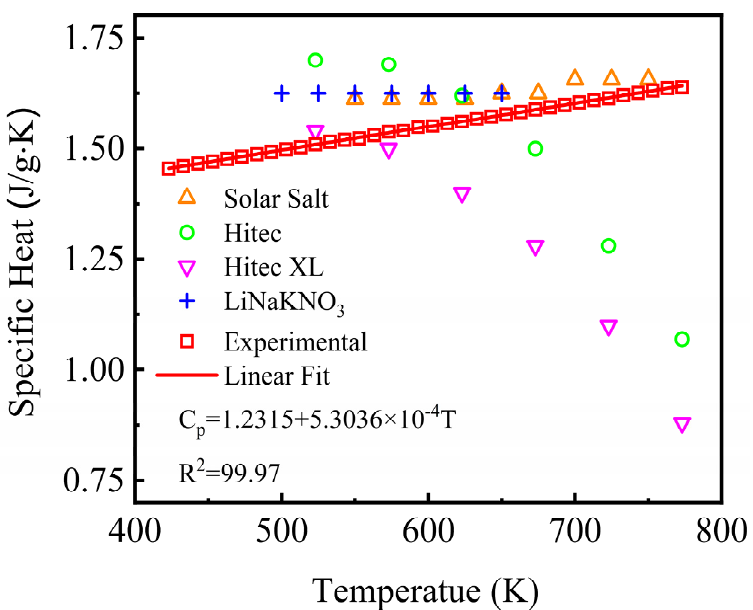
Figure 8. Specific heat capacity of the NaNO 3 -KNO 3 -Ca(NO 3 ) 2 (16:48:36 wt%) eutectic ternary salt and other currently used nitrate/nitrite systems.